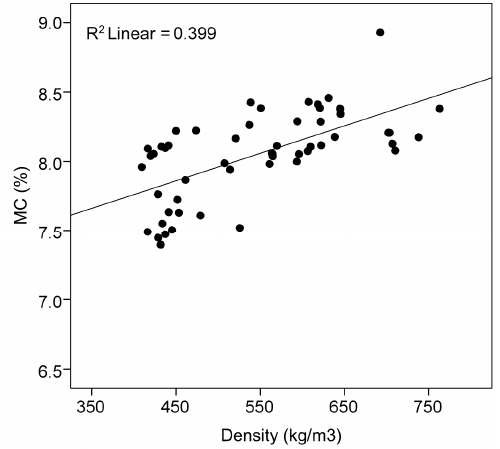
Figure 4. Variation in moisture content and density of E. globulus samples.